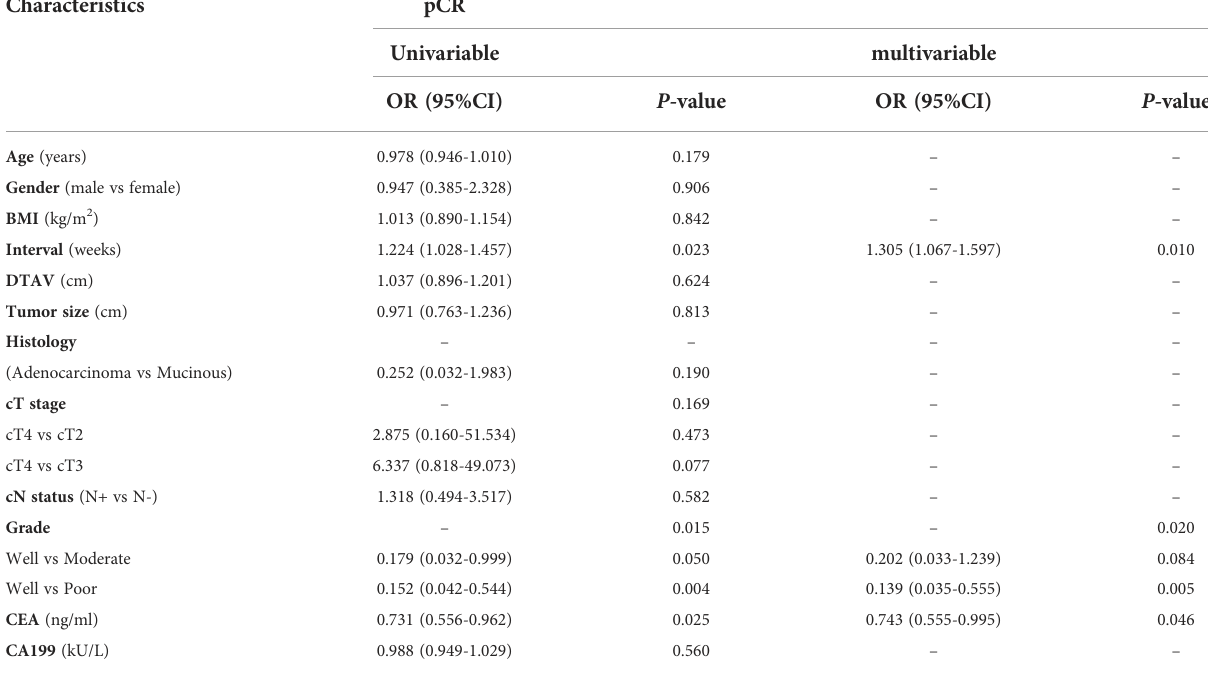
TABLE 2 Univariate and multivariate logistic regression analyses for clinical parameters.